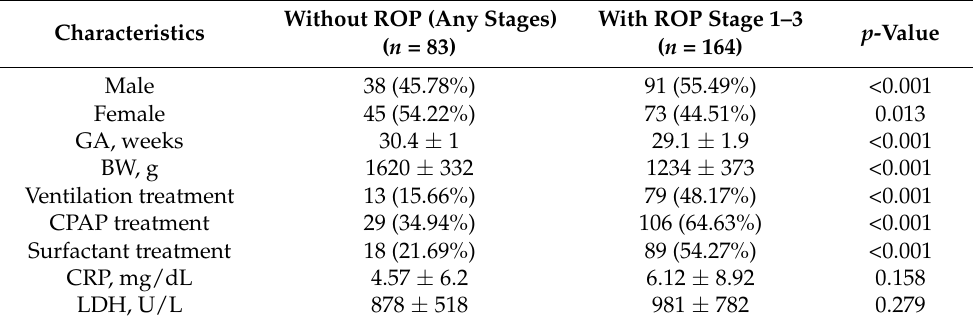
Table 2. Univariate comparison of perinatal characteristics in infants who developed ROP (Stage 1–3) and those who did not.